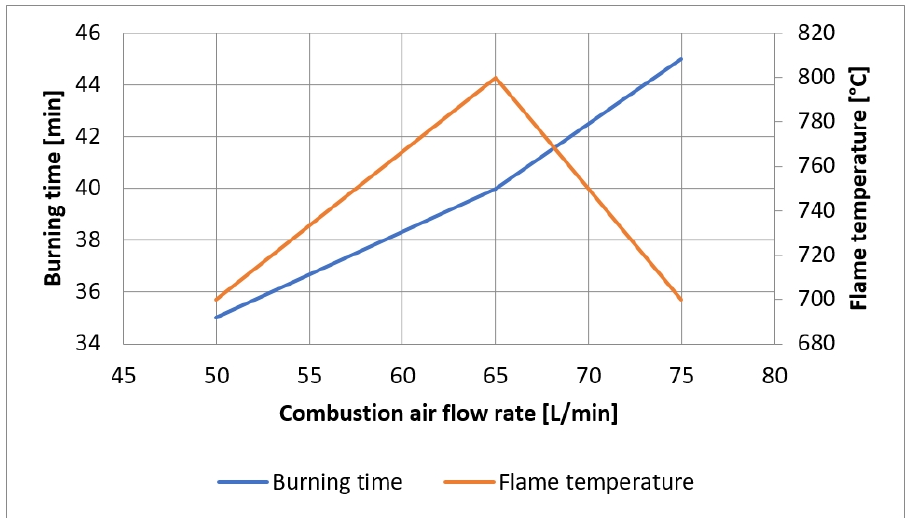
Figure 19. Variation in the burning time and flame temperature depending on the combustion air flow rate.